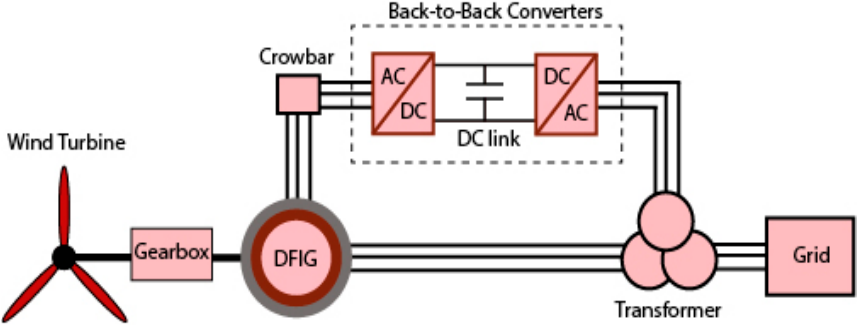
Figure 3. Double-Fed Induction Generator.